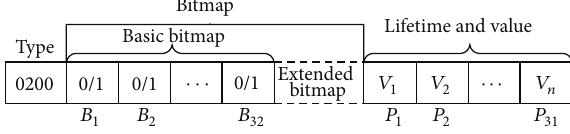
Figure 2: The data structure of PPS